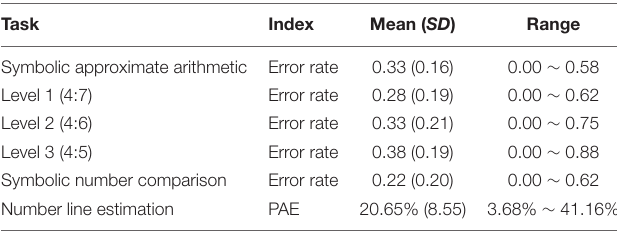
TABLE 1 | Descriptive statistics of kindergartners’ performance on measures of symbolic approximate arithmetic ability, symbolic number comparison ability, and number line estimation ability.